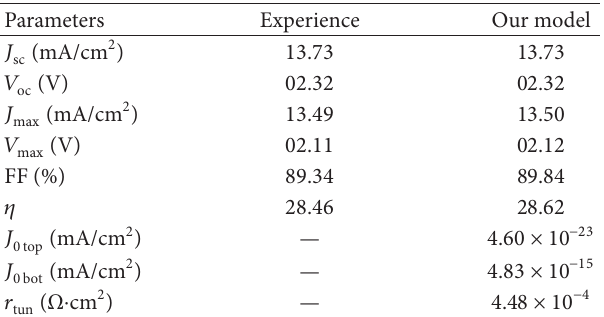
Table2:Parametersextractedfromourmodelandcomparisonwith